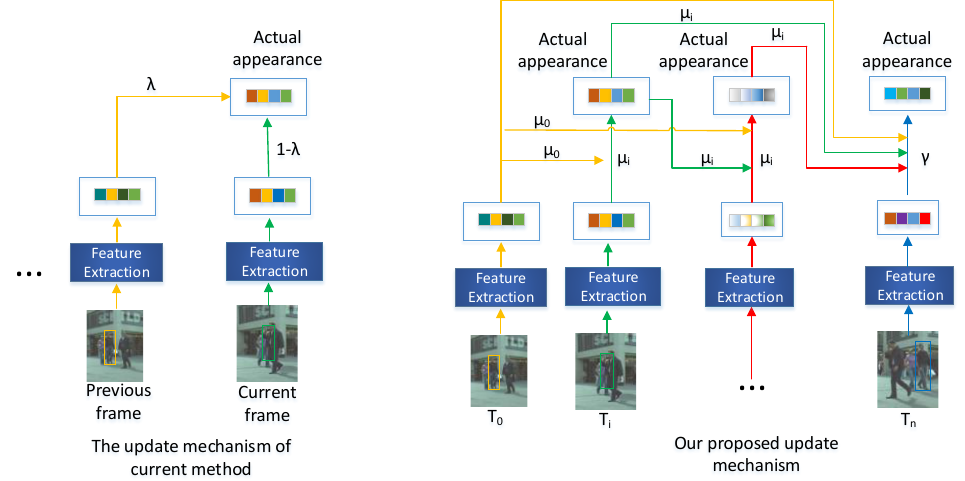
Figure 2. The detailed information of the appearance template update mechanism of the current method and the appearance template update mechanism of our proposed method. λ , γ , and µ i are